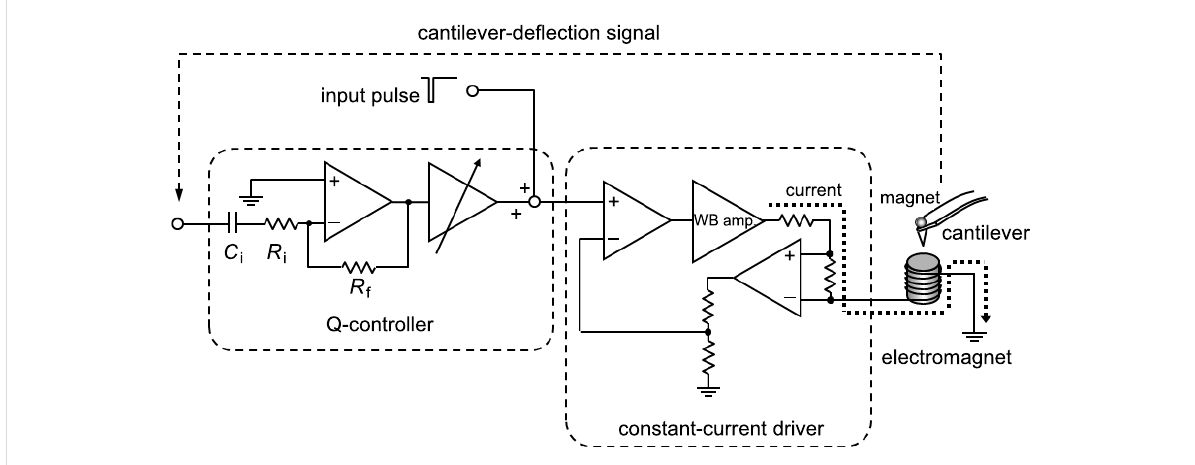
Figure 1: Schematic diagram of cantilever regulation by means of magnetic force. The system consists of a Q-control circuit with a differentiator and a wide-band constant-current driver.